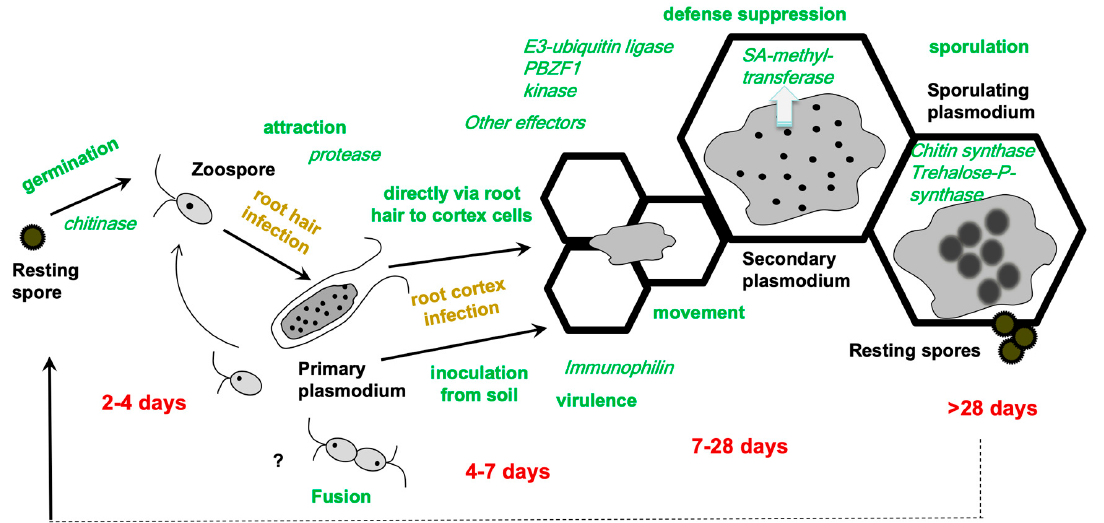
Figure 2. The most important life stages are given together with the approximate time points of their occurrence based on different host plants and/or isolates or experimental conditions. Typical time intervals are indicated below in red, in green the various processes that are related to P. brassicae colonization are shown, and in brown, the two different phases of the life cycle are indicated. In italics, some important P. brassicae genes/proteins are given for which a function has been experimentally shown. The identification and characterization of the effectors are described in Section 4.1.